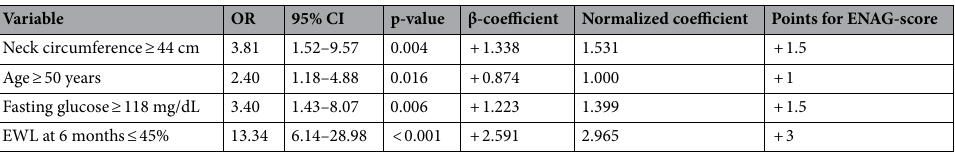
Table 4. Prediction of BS failure, defined as %EWL < 50% at 2 years, by multivariate logistic regression after stepwise backward selection of pre-surgical and early post-surgical data; ENAG-score point assignment